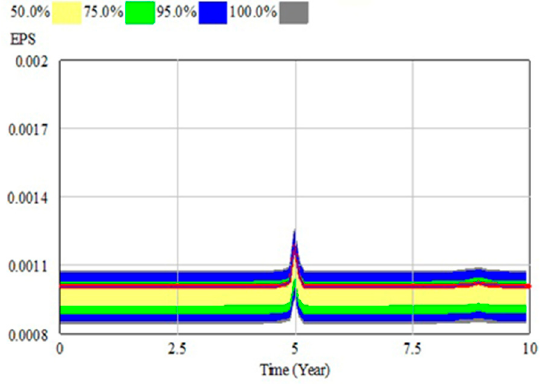
Figure 25. SD sensitivity trace range of ERL variable.